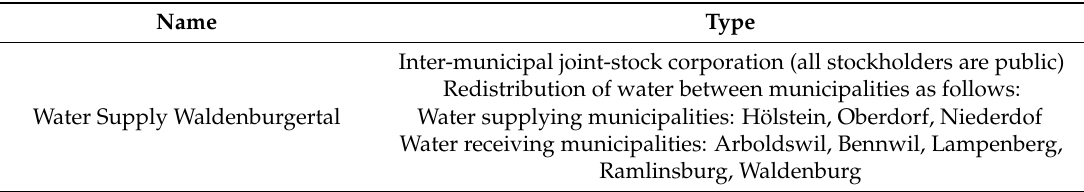
Table 2. Overview of water suppliers and types in Case 2.